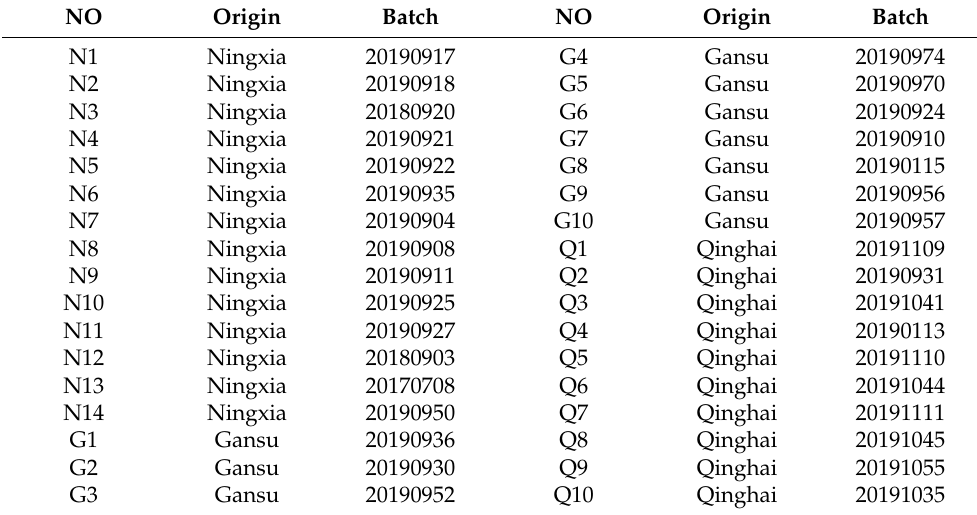
Table 1. The information of 34 batches of LB.